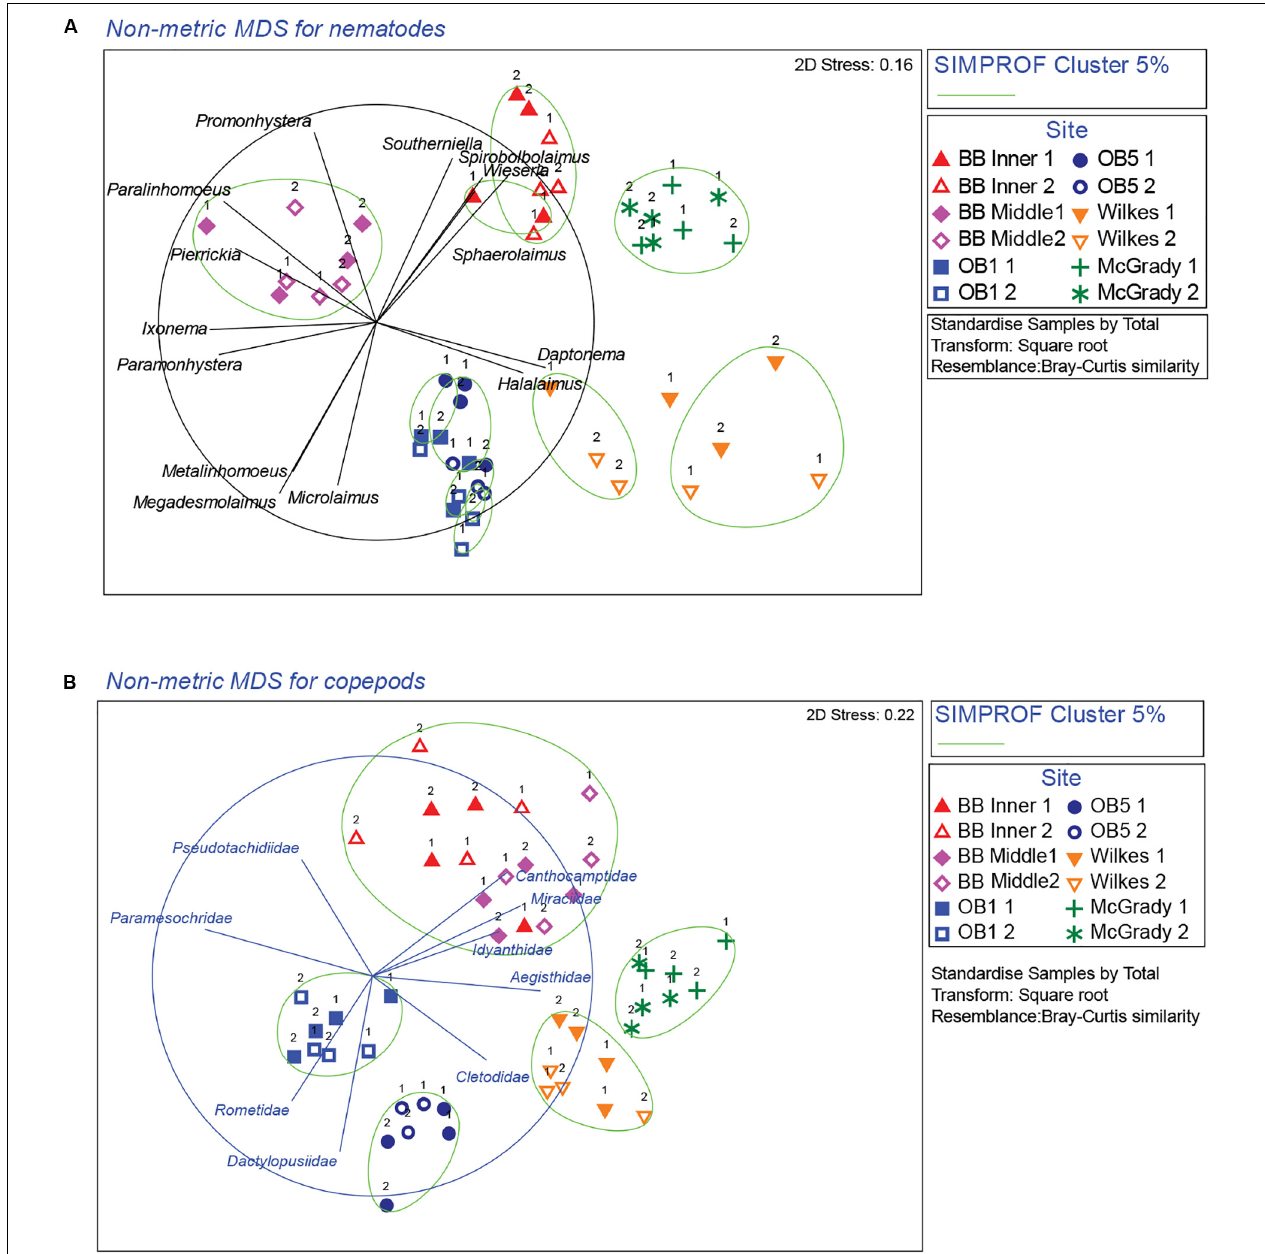
FIGURE 3 | nMDS ordinations of nematode and copepod communities around Casey Station. Numbers next to symbols represent the different plots within each site. The taxa most responsible for contributing to differences among locations were determined using vector plots overlaid on the nMDS and similarity percentage analysis (SIMPER). (A) Nematodes, (B) copepods. Vectors are taxon correlations with nMDS axes (nematode correlation cut-off: 0.7, copepod correlation cut-off: 0.6; with circle representing correlation value of 1). Ellipses on the plot represent significant cluster groups based on SIMPROF